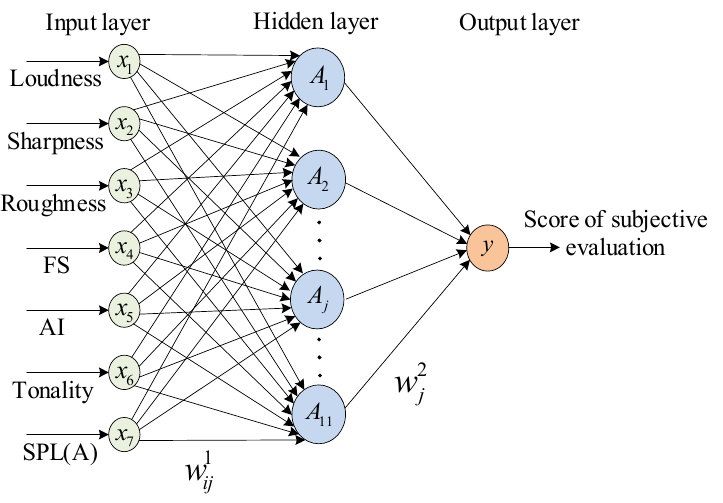
Figure 13. Network topology structure of genetic algorithm back propagation artificial neural network (GA-BP ANN).